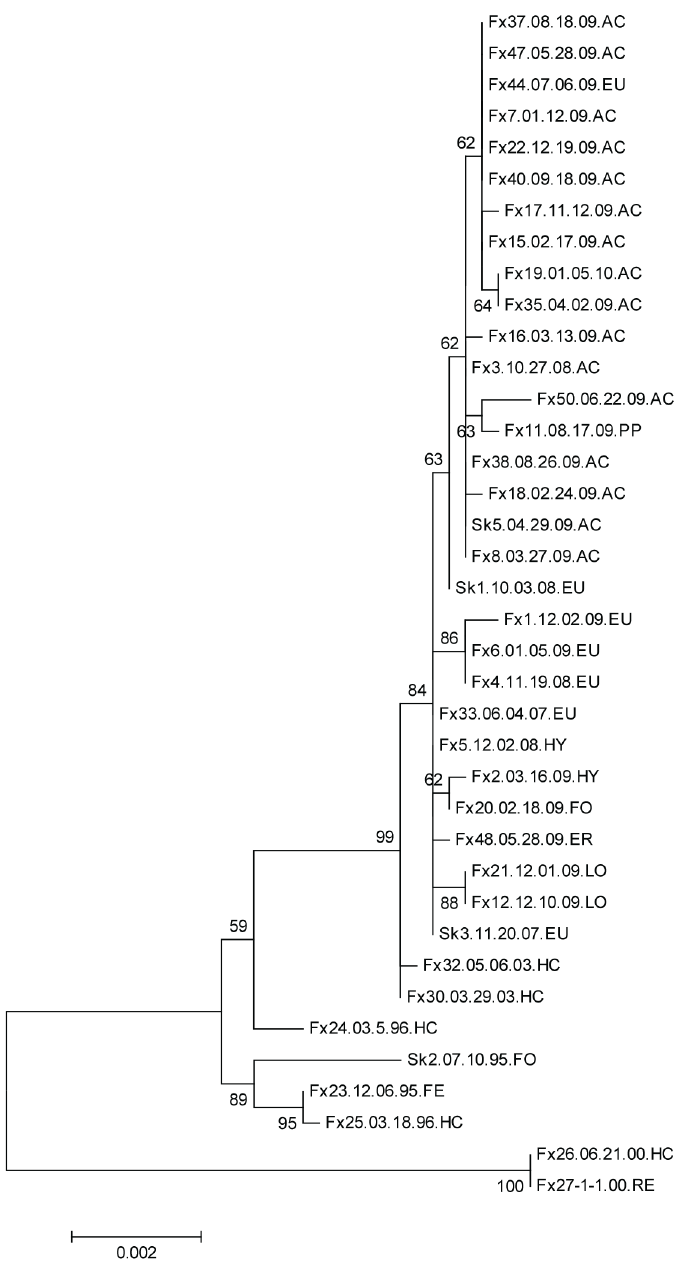
Figure 4. Phylogram generated from L gene nucleotide sequences of Humboldt Co. skunk variant rabies samples. The evolutionary history was inferred by using the Maximum Likelihood method as described for Figure 1. The analysis involved 38 nucleotide sequences. All positions with less than 95% site coverage were eliminated. There were a total of 3979 positions in the final dataset. Samples and regions are labeled as previously